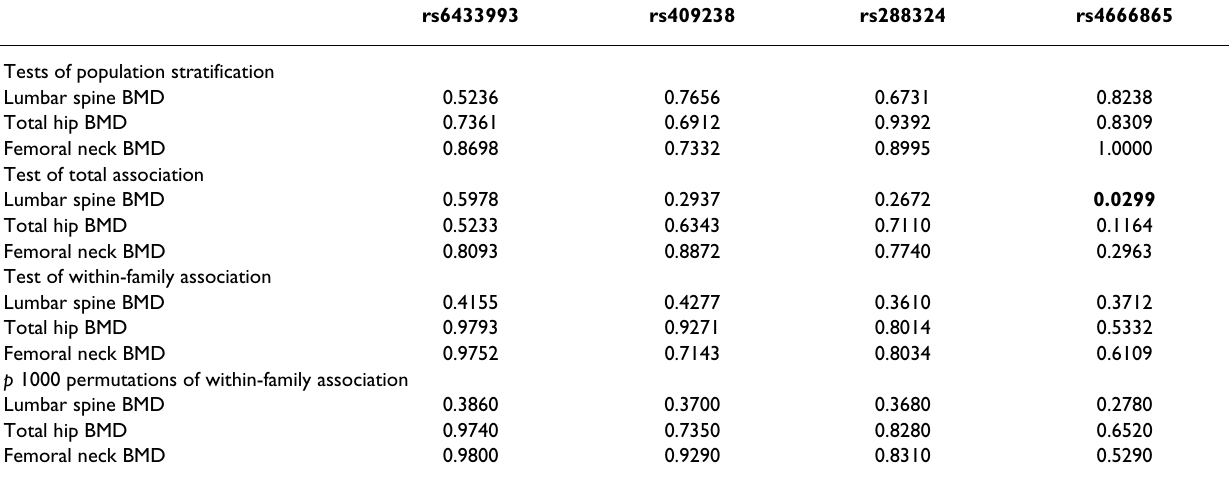
Table 5: P values of QTDT analyses for FRZB gene and BMD in male-offspring nuclear families